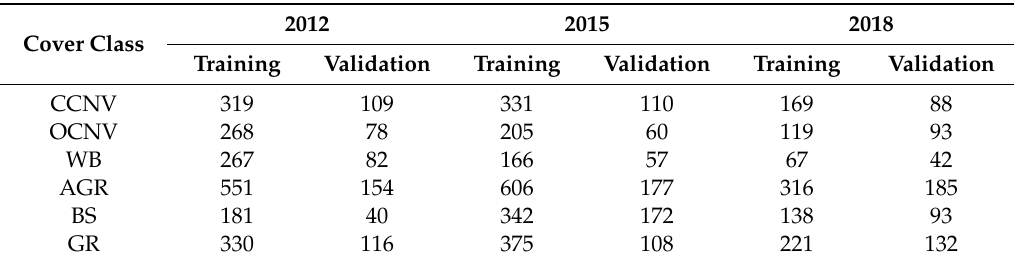
Table 3. Number of training and validation samples per class and per year. CCNV—close canopy natural vegetation; OCNV—open canopy natural vegetation; WB—water bodies; AGR—agriculture; BS—bare soils;